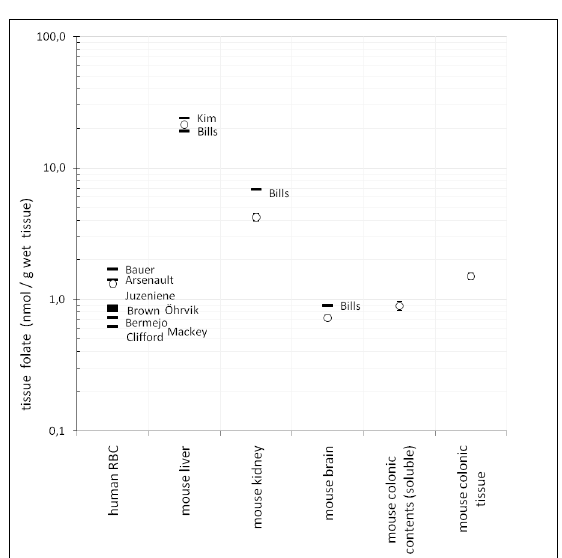
Figure 4. Levels of folate in tissues: comparison of FP method with published data. Comparison of published values ( ) for folate in various tissues with values o generated by the FP method ( ). The source references for each datapoint are indicated alongside the data. Table 1. Data from figure 4 showing standard devia- tion and coefficient of variation values for FP data . nmol folate /g wet tissue OR (nmol folate/ml packed volume of erythrocytes)Data from figure 4 showing standard deviation and coefficient of variation values for FP